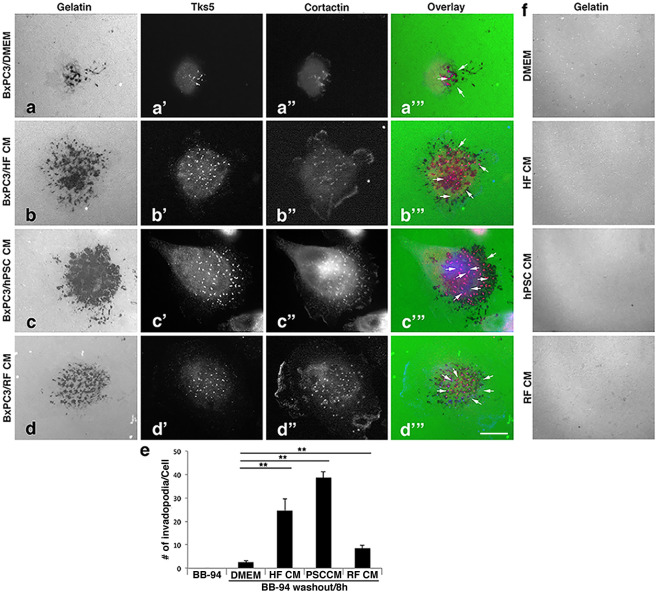
Conditioned medium from fibroblasts stimulates the accumulation of functional invadopodia in pancreatic cancer cells.The presence of CM from fibroblasts increases the number of invadopodia in PDAC cells. (a-d”) Representative images of BxPC3 cells seeded onto green fluorescent gelatin-coated coverslips and incubated with the MMP inhibitor BB-94 (2μM) overnight. (a-d) The inhibitors were removed by extensive washing and the cells were allowed to initiate gelatin degradation by incubation for 8 h with either DMEM alone (a, a’, a”, a”‘), CM collected from HFs (b, b’, b”, b”‘), hPSCs (c, c’, c”, c”‘), or RFs (d, d’, d”, d”‘). Cells were then fixed and stained with antibodies to the invadopodial marker Tks5 and cortactin. Scale bar = 10μm. (e) Quantification showing that CM from HFs, hPSCs, and RFs increased the number of invadopodia in BxPC3 cells markedly compared to the BB-94 and DMEM controls (≥10 cells per condition). Graphs represent averages ± SEM from 3 independent experiments. **p <0.01. (f) No degradation was observed when conditioned medium from the indicated cells was incubated with green fluorescent gelatin-coated coverslips for 8 hours.